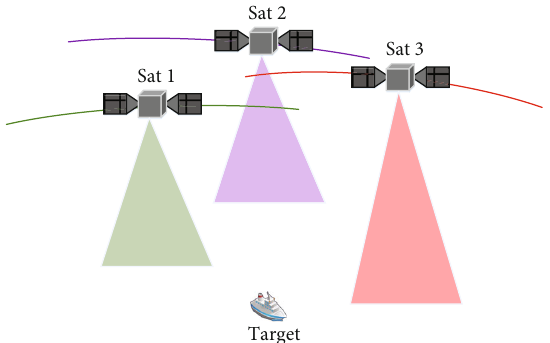
Figure 1: Potential target searching task mode scheme.